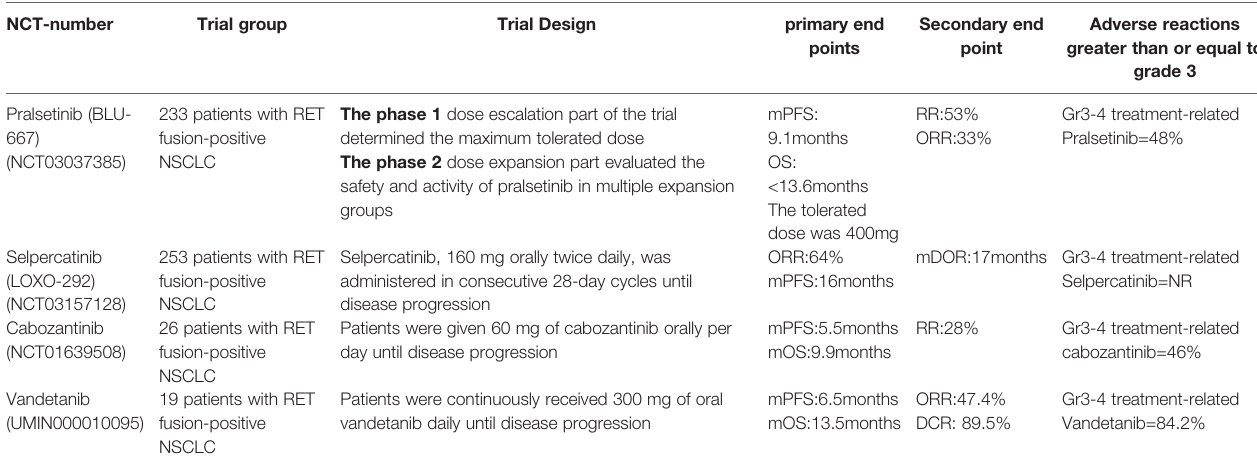
TABLE 1 | MKI and TKI in RET fusion